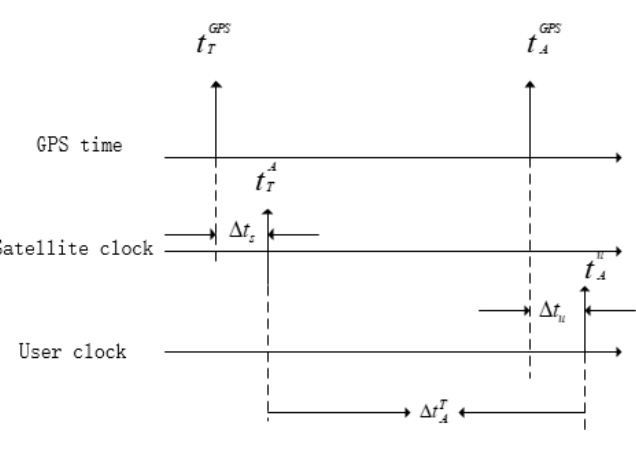
Figure 2. GPS time-transfer process.